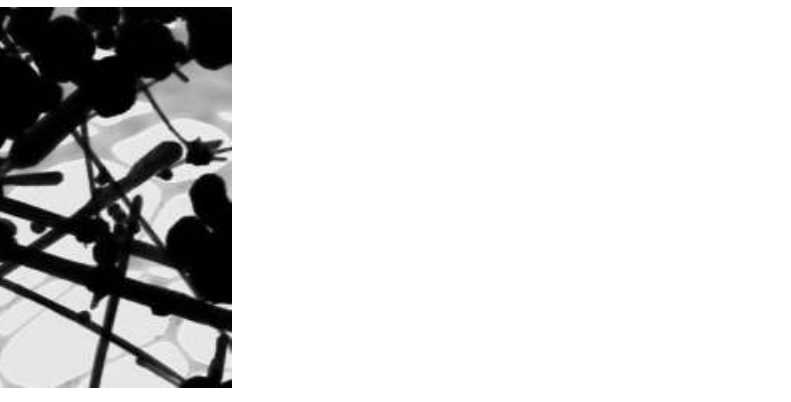
Figure 16. TEM image of copper nanowires with 37 mM of copper precursor (scale bar 0.5 µm).